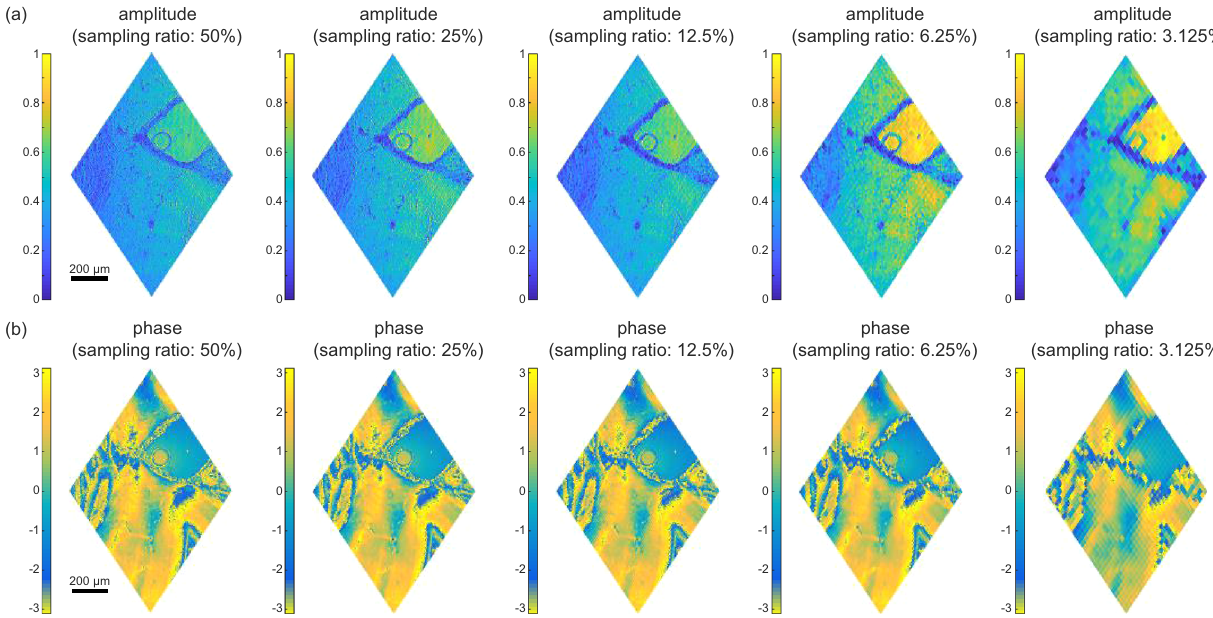
Fig. 5 Reconstruction of holographic images for the unstained tissue from mouse brains with compressive sensing. The amplitude and wrapped phase